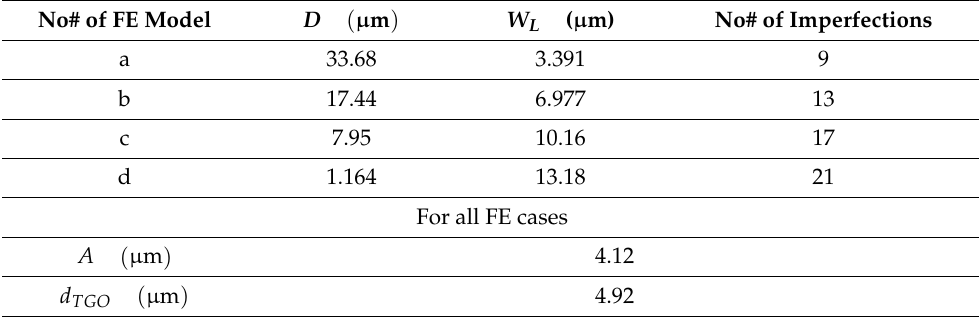
Figure 32. Global spacing parameter D and local width of imperfection W L as a function of the number of interfacial imperfections. Table 4. Parameters used in FE analysis in terms of the global spacing